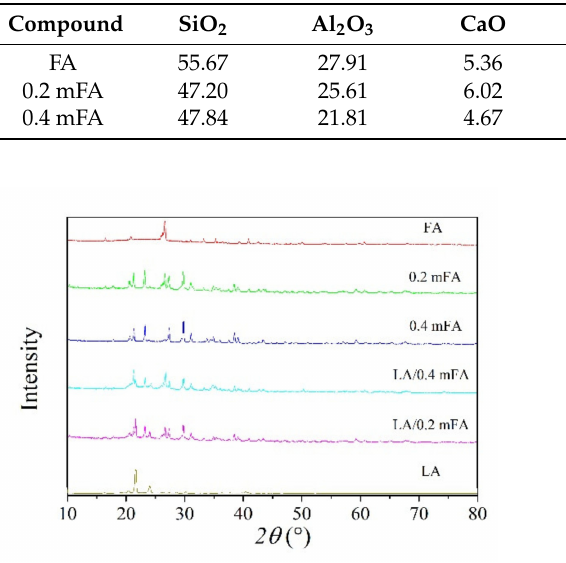
Figure 3. SEM images of: ( a ) fly ash (FA); ( b ) lauric acid (LA)/FA; ( c ) 0.2 modified fly ash (mFA0); ( d ) LA/0.2 mFA; ( e ) 0.4 mFA and ( f ) LA/0.4 mFA. Table 1. Components of FA and mFA by X-ray fluorescence (XRF) analysis.